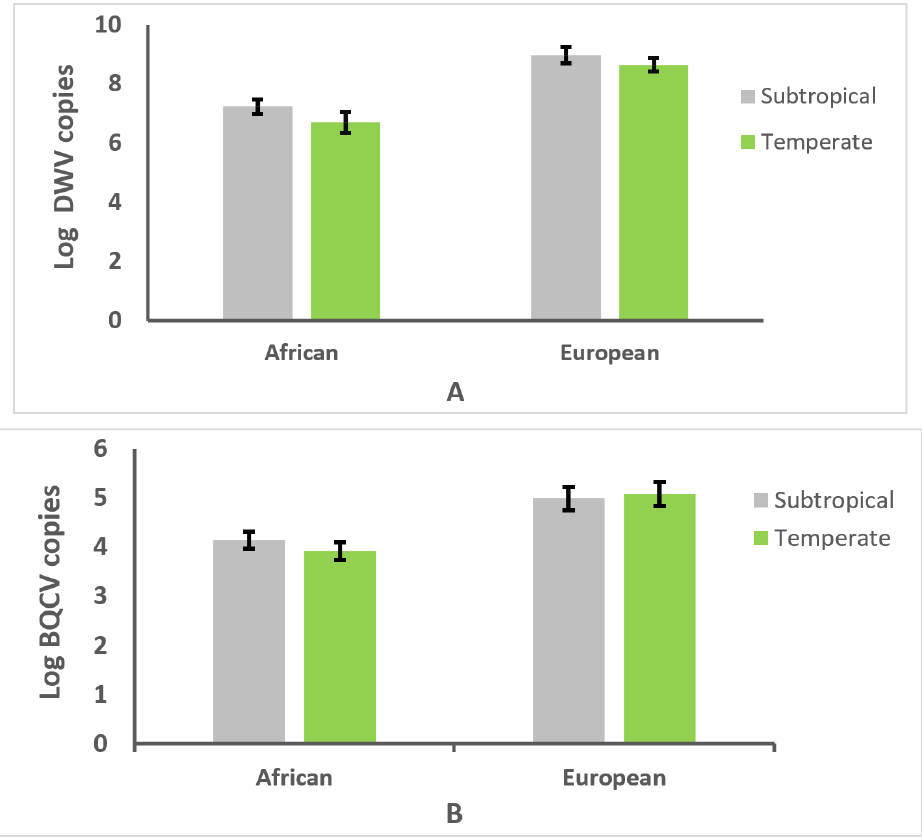
Figure 4. Mean number copies of deformed wing virus (DWV) ( A ) or black queen cell virus (BQCV) ( B )/µg of RNA × 10 6 ± SE in worker honey bees of African and European genotype (with the same morphotype and mitotype, respectively) from 59 colonies located in subtropical and temperate climates. Data transformed to natural logarithm are